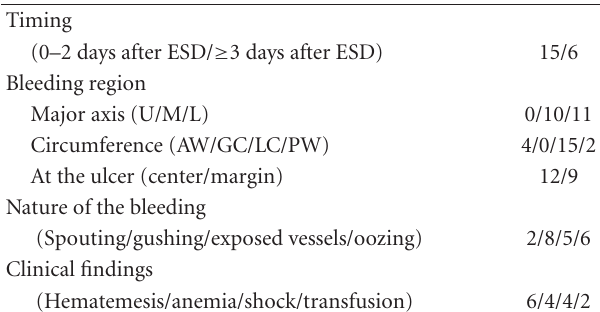
Table 4: Analysis of the 21 bleeding